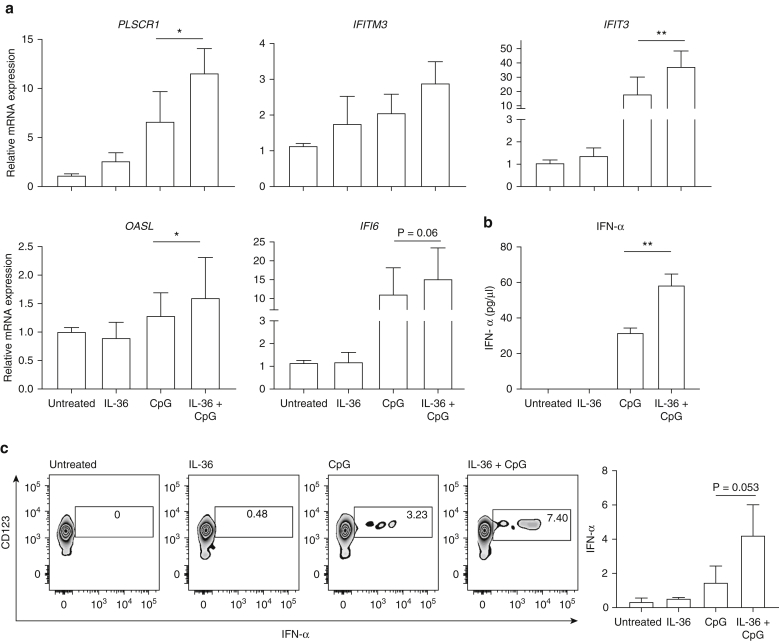
IL-36 enhances the production of IFN-α downstream of toll-like receptor 9. (a) PBMCs were stimulated with CpG for 6 hours, in the presence or absence of IL-36 pretreatment (6 hours). The expression of IFN signature genes was measured by real-time PCR. Data represent the mean ± SEM of results obtained in three independent donors, each stimulated in triplicate. (b) After PBMC stimulation, IFN-α production was measured by ELISA. Data represent the mean ± SEM of results obtained in two independent donors, each stimulated in triplicate. (c) After PBMC stimulation, the percentage of IFNα+ pDCs was determined by flow cytometry. A representative set of plots is shown (left), together with the data obtained in three independent healthy donors (right). *P < 0.05; **P < 0.01 (Friedman test, with Dunn posttest). CpG, CpG-containing DNA; PBMC, peripheral blood mononuclear cell; pDC, plasmacytoid dendritic cell; SEM, standard error of the mean.